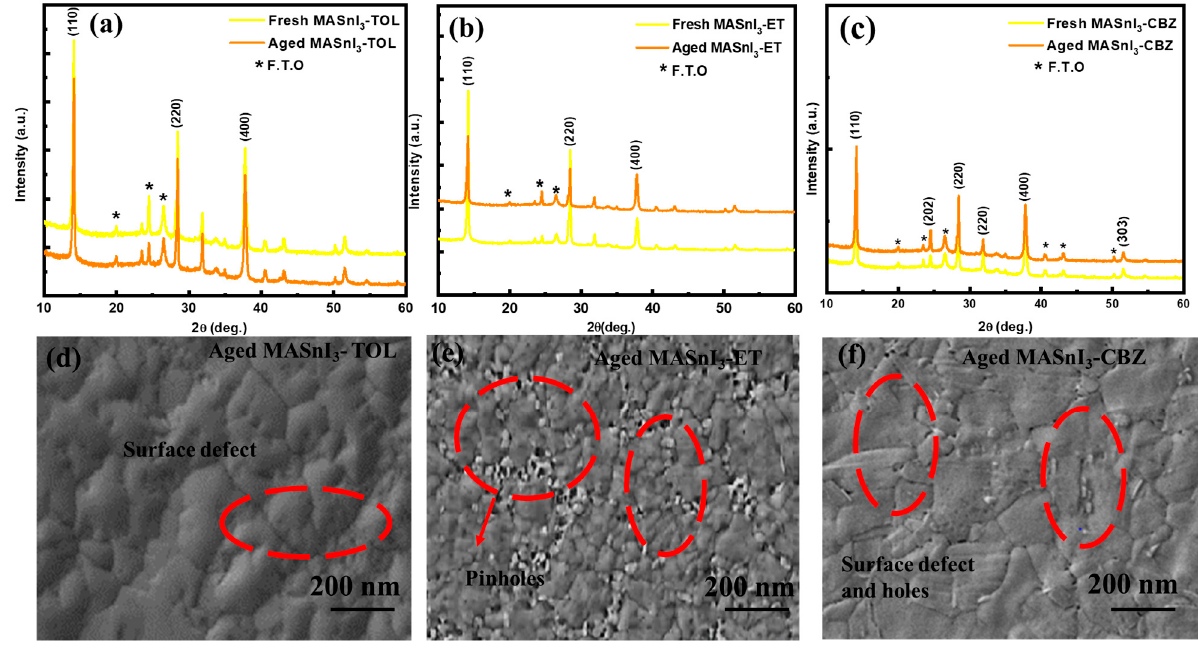
Figure 4. Degradation study of MASnI 3 films treated with different antisolvents. ( a ) XRD pattern of fresh and four-week-old MASnI 3 films treated with toluene, ( b ) XRD pattern of fresh and four-week-old MASnI 3 films treated with diethyl ether, ( c ) XRD pattern of fresh and aged MASnI 3 films treated with chlorobenzene, ( d ) SEM image of an aged MASnI 3 film treated with toluene, ( e ) SEM image of a four-week-old MASnI 3 film treated with diethyl ether ( f ) SEM image of a four-week-old MASnI 3 film treated with